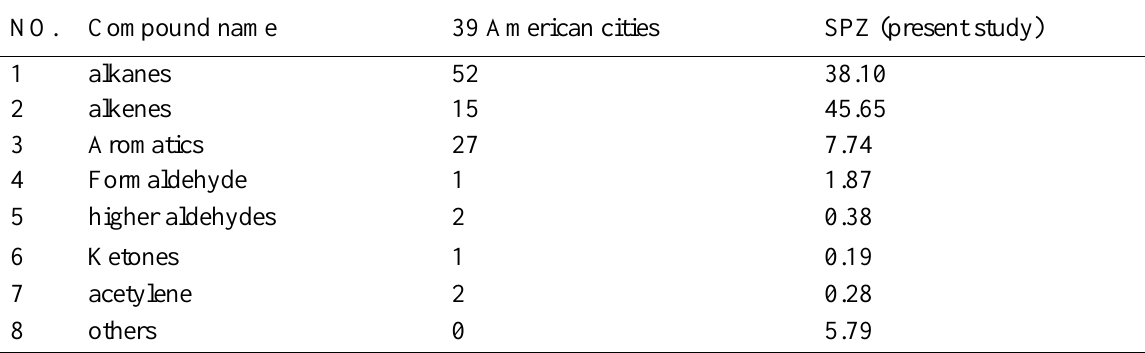
Table 2. The Relative amount of hydrocarbon groups in the base ROG mixture used to represent emissions from all sources in averaged conditions of 39 American urban used to prepare MIR and SAPRC mechanism and contribution of hydrocarbon groups in mass-based EI of the SPZ (by carbon